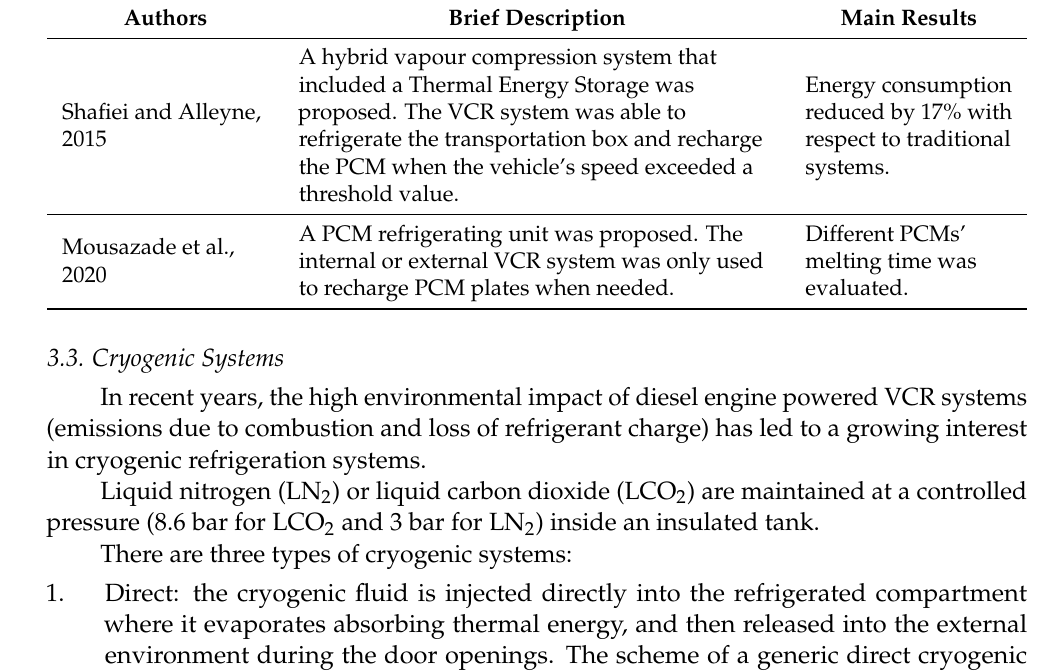
Table 3. Summary of proposed PCMs applications in refrigerated transport.